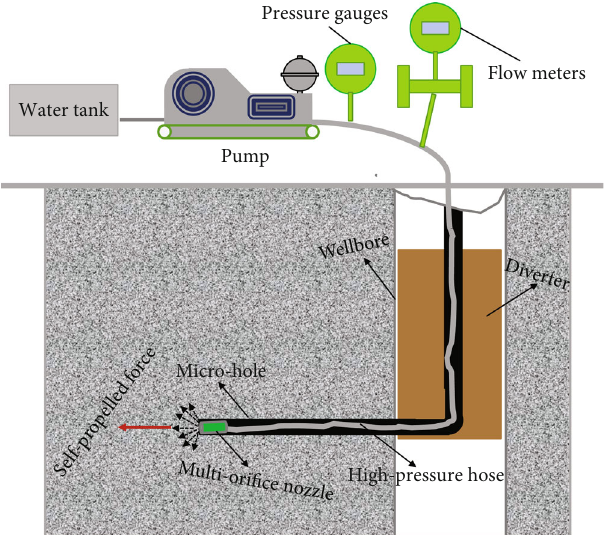
Figure 10: Schematic of an RJD system with high-pressure water.